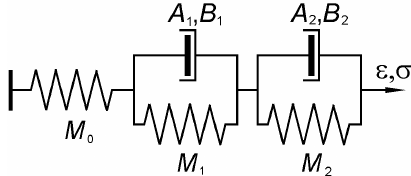
Fig. 6. Rheological model of a solid body with two elements plastic flow ( M 0 is the elastic modulus of Hooke's